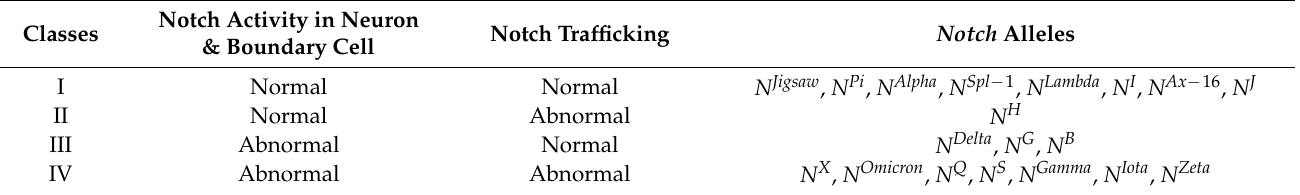
Table 2. Notch missense mutations classified by types of defects in Notch activity and